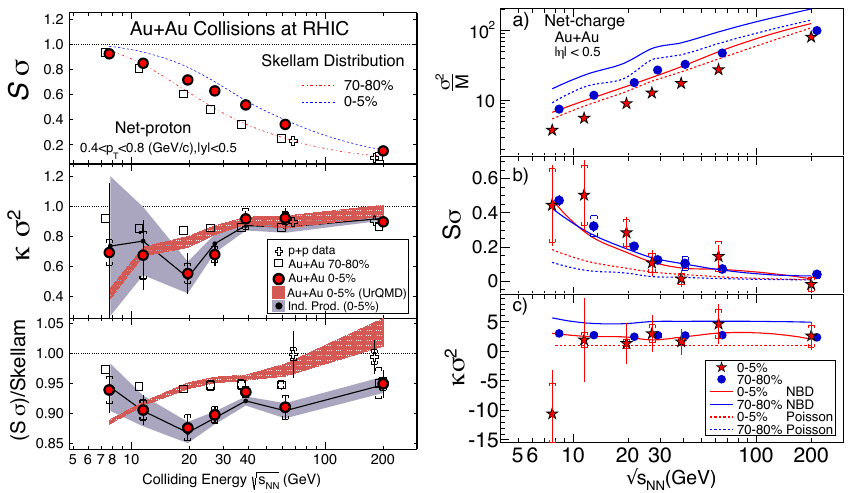
Figure 27. The energy dependence of appropriate combinations of the moments—mean ( M ), variance ( σ 2 ), skewness ( S ), and kurtosis ( κ )—of the multiplicity of conserved charges at mid-rapidity in √ s NN = 7.7 to 200 GeV, and for two centralities, Au + Au collisions for seven energies ranging from the most central (0%–5%) and peripheral (70%–80%) bins. Left : The collision energy and centrality dependence of the net-proton S σ and κσ 2 from Au + Au and p + p collisions at RHIC (adapted from Ref. [365]); Right : The beam-energy dependence of the net-charge multiplicity distributions moments ( a ) σ 2 / M , ( b ) S σ , and ( c ) κσ 2 , after all corrections. Reproduced from Ref. [367]. The results from the Poisson and the Negative Binomial Distribution (NBD) baselines are superimposed. The values of κσ 2 for the Poisson baseline are always